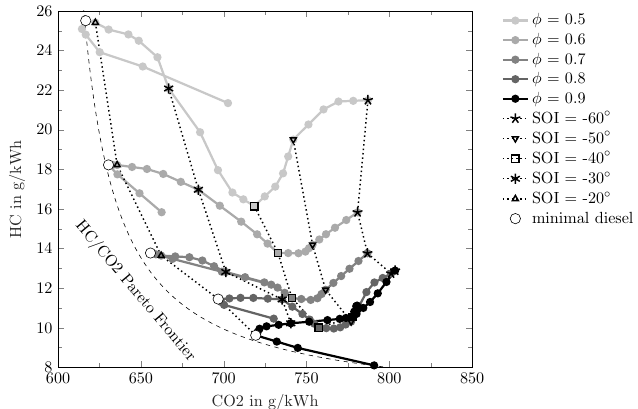
Figure A4. Measured CO 2 and HC emissions for various configurations of Diesel injection and equivalence ratio at the same center of combustion and brake mean effective